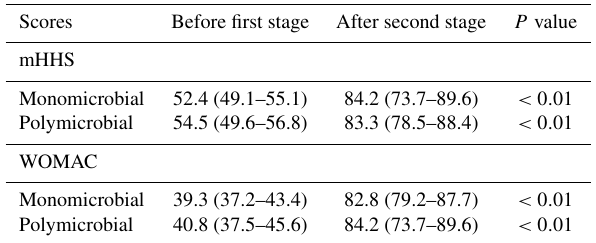
Table 4. Score values before first stage and after second stage of hip revision.